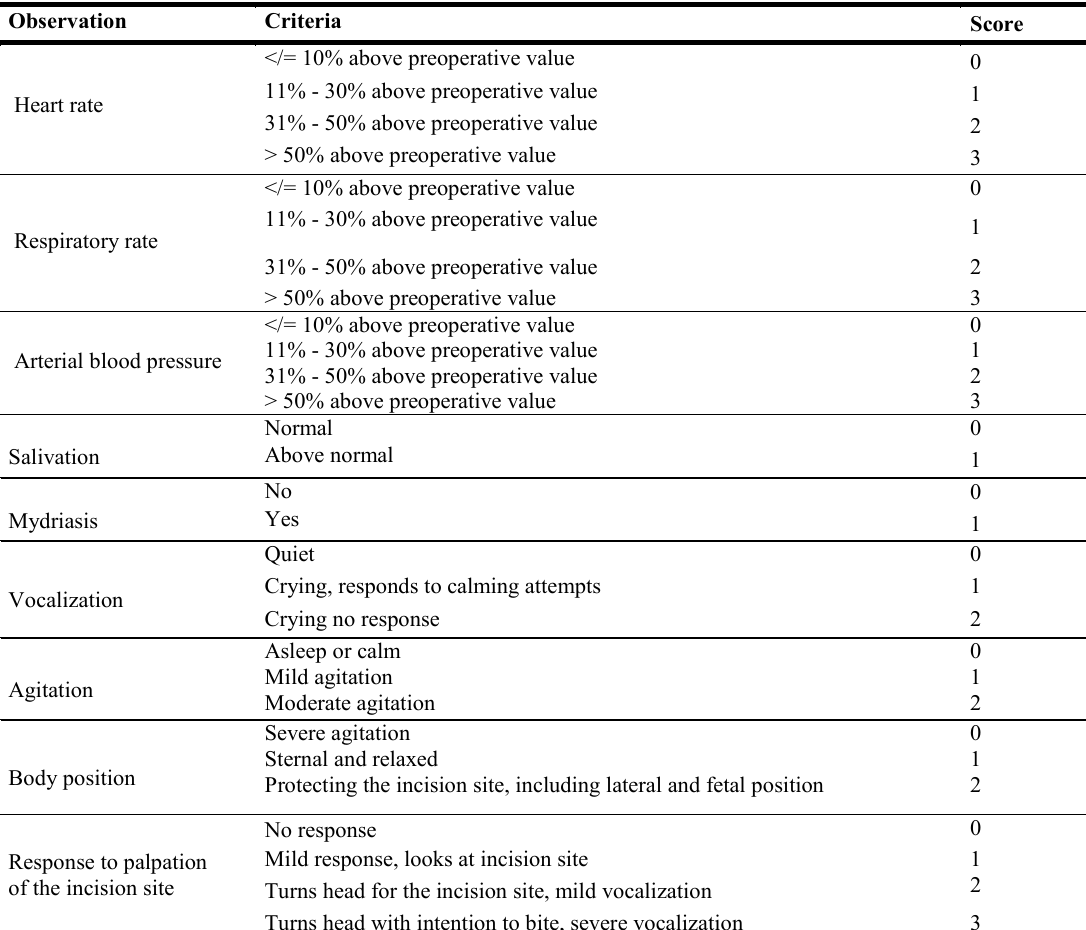
TABLE 1 - Criteria used for scoring postoperative pain in dogs.